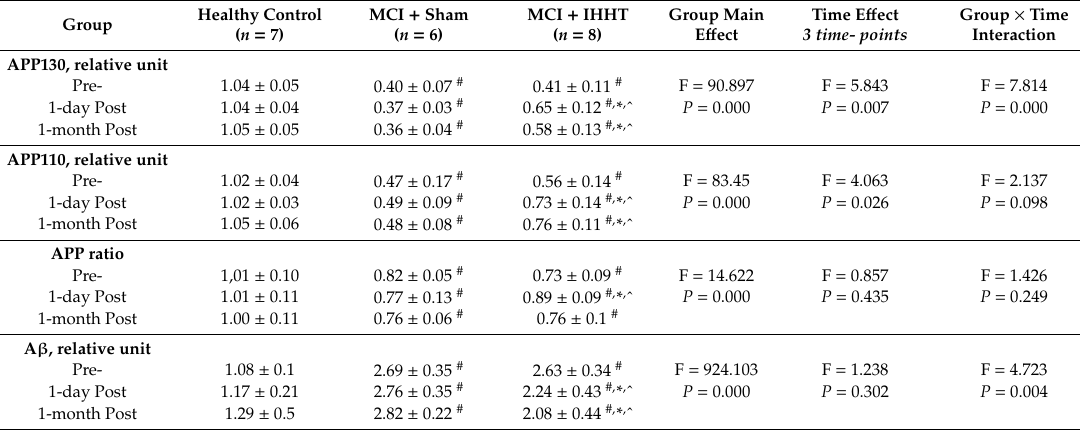
Table 2. Neutrophil extracellular traps (NETs) formation in neutrophils culture under three-week sessions of sham training or